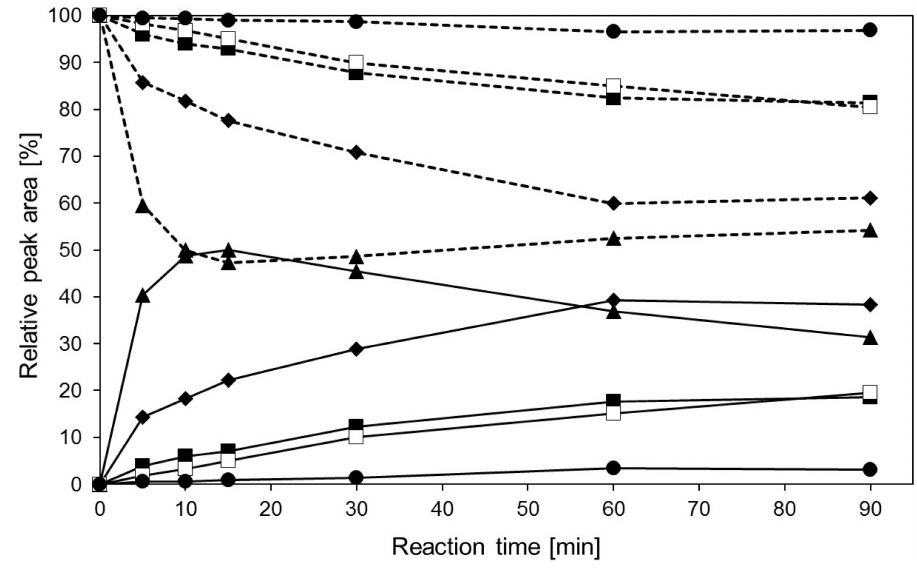
Figure 4. Comparison of transgalactosylation reactions with recombinant β -glycosidase from Pyrococcus under MWI and TH starting from 50 mM GlcNAc-linker- t Boc. Analytical HPLC were used for detection of reactant (GlcNAc-linker- t Boc, dashed lines) and main product (Gal β (1,4)GlcNAc-linker- t Boc, solid lines) at 254 nm. Experimental conditions: 100 W MWI ( (cid:4) ) with an average temperature of ~12 ˝ C, 300 W MWI ( (cid:7) ) with an average temperature of ~25 ˝ C, 85 ˝ C TH ( (cid:78) ), 30 ˝ C TH ( ˝ ), and 12 ˝ C TH ( ). 1 mL reaction mixture contained 12 U/mL enzyme solution and 600 mM lactose in 25 mM citrate-phosphate buffer pH 5.5. The measured data with standard deviations are listed in Table